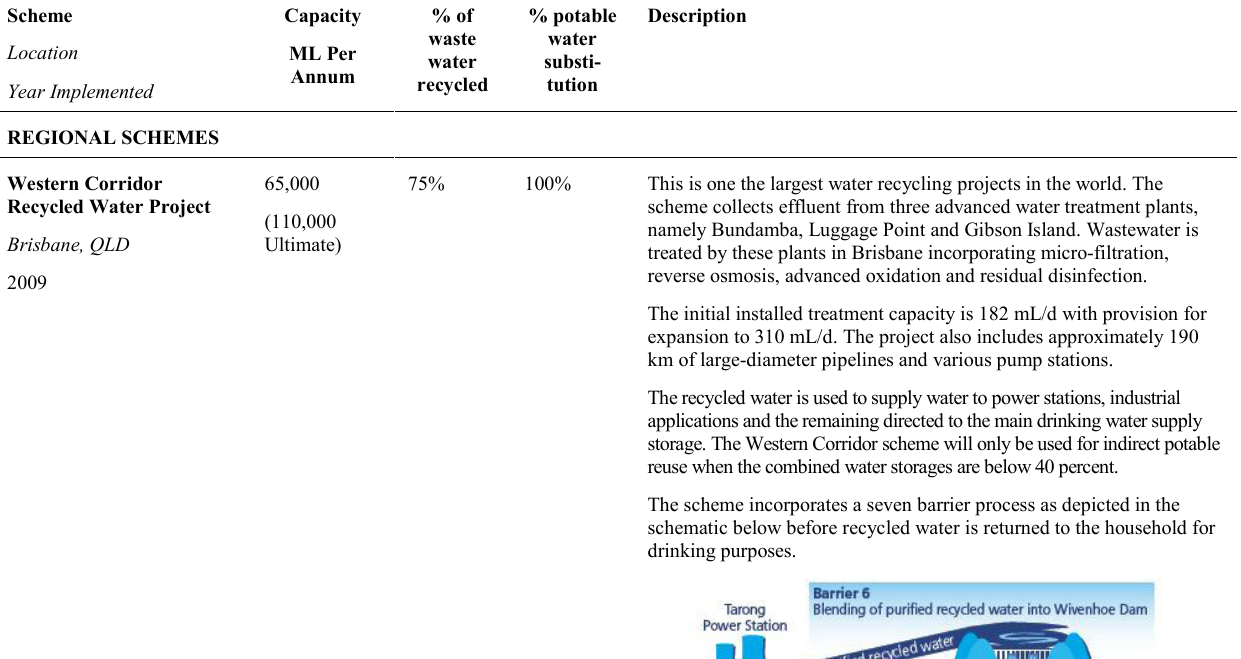
Table 1. Australian Water Recycling